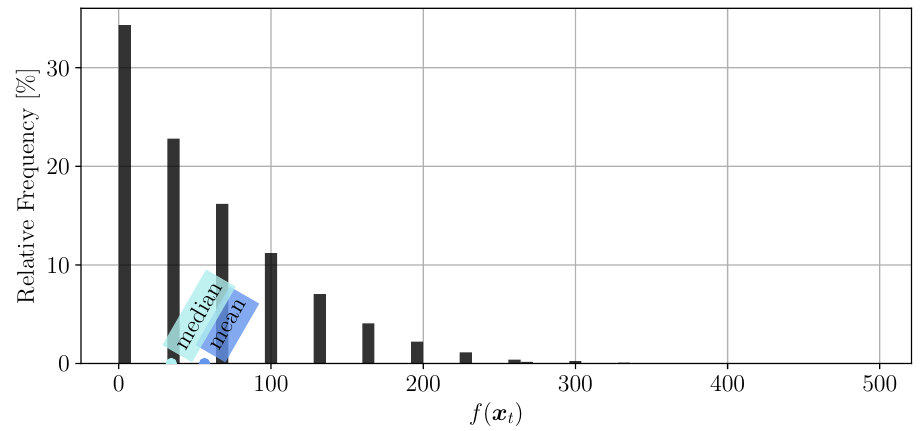
Figure 2. Exemplary Loda outlier score values including the mean and